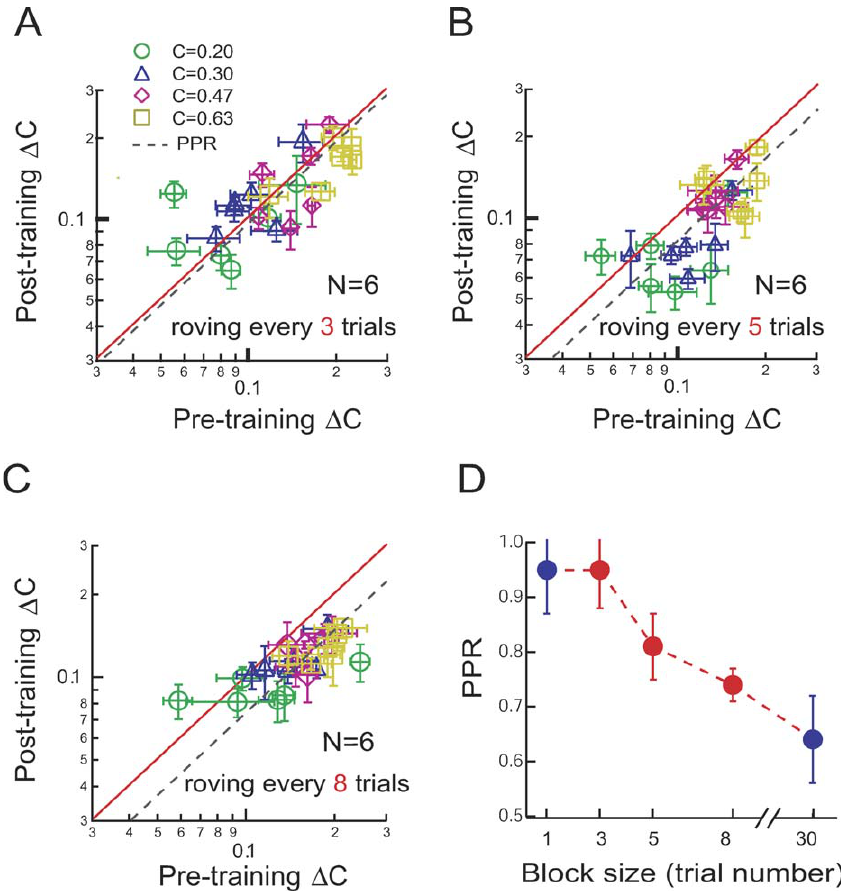
Figure 4. The Minimal Block Size for Perceptual Learning of Multiple Stimuli (A–C) Post- versus pre-training contrast thresholds with each roving contrast practiced (A) every three consecutive trials ( F 1,5 ¼ 0.60, p ¼ 0.474), (B) five consecutive trials ( F 1,5 ¼ 9.26, p ¼ 0.029), and (C) eight consecutive trials ( F 1,5 ¼ 53.9, p ¼ 0.001). (D) Summary of learning effects in various block-size conditions. Data for one-trial and 30-trial block-size conditions (blue symbols) had been reported previously [6] and were used here for reference. Each datum represents the mean PPR over four contrast conditions and all